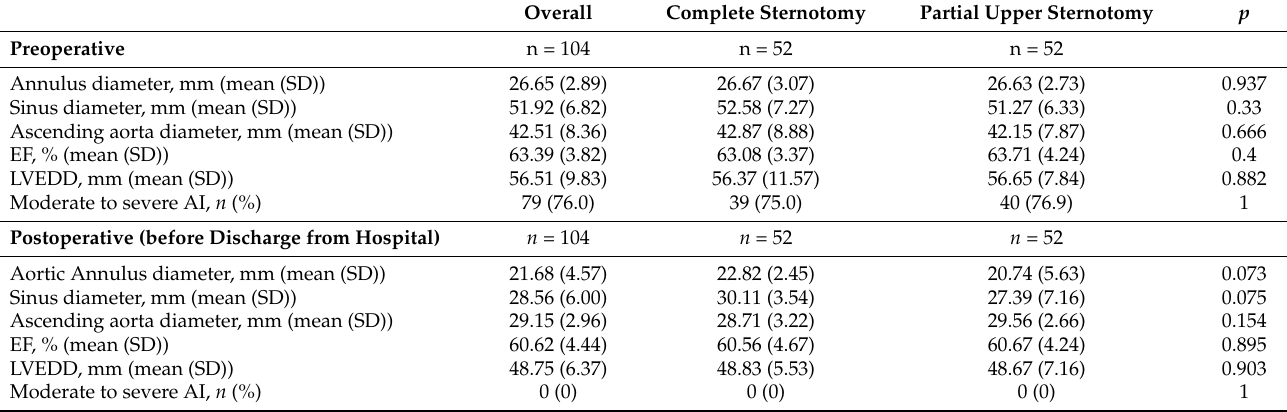
Table 4. Echocardiographic data of the propensity-matched